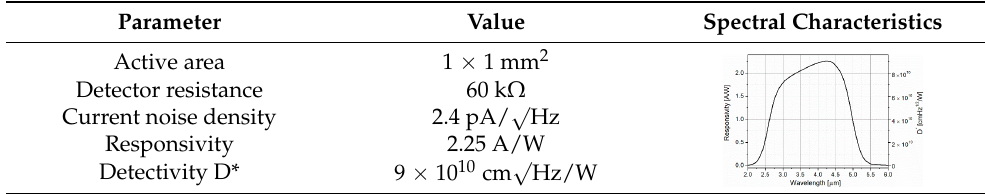
Table 4. Parameters of the detection module.